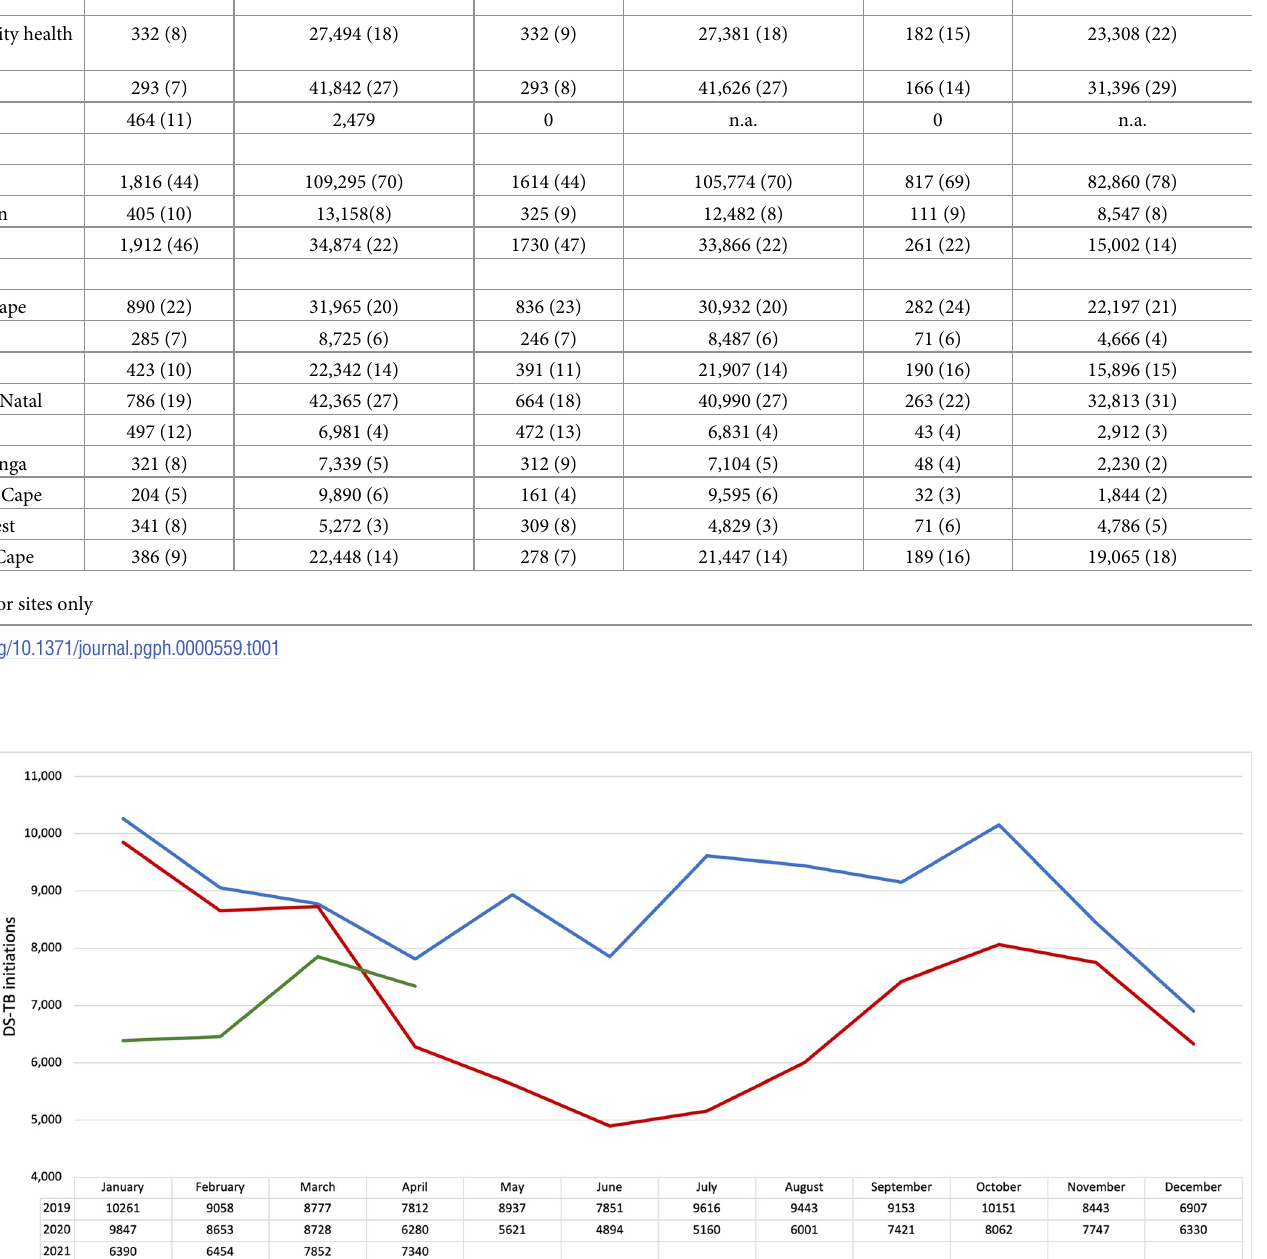
PLOS Global PublicHealth | https://doi.org/10.1371/journal.pgph.0000559 October 11,